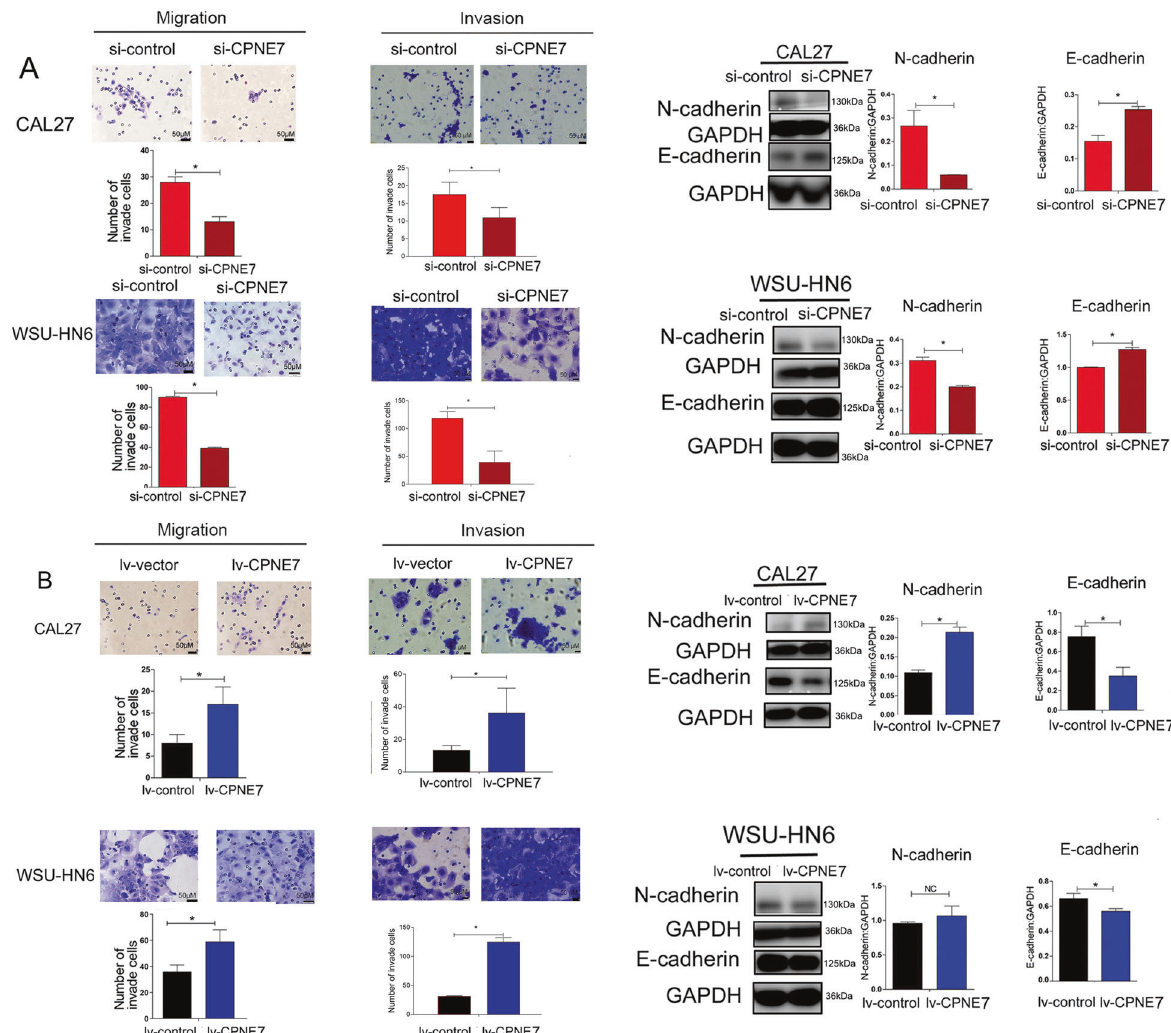
Fig. 5 Overexpression and knockdown of CPNE7 in MSCs veri fi ed that CPNE7 promote metastasis of OSCC cell lines. A Knockdown of CPNE7 in OSCC-MSCs suppressed the migration of OSCC cell lines through EMT. B Overexpression of CPNE7 in OLK-MSCs promoted the migration of OSCC cell lines through EMT. The tests were repeated three times. Data were expressed as means ± SD. * p <